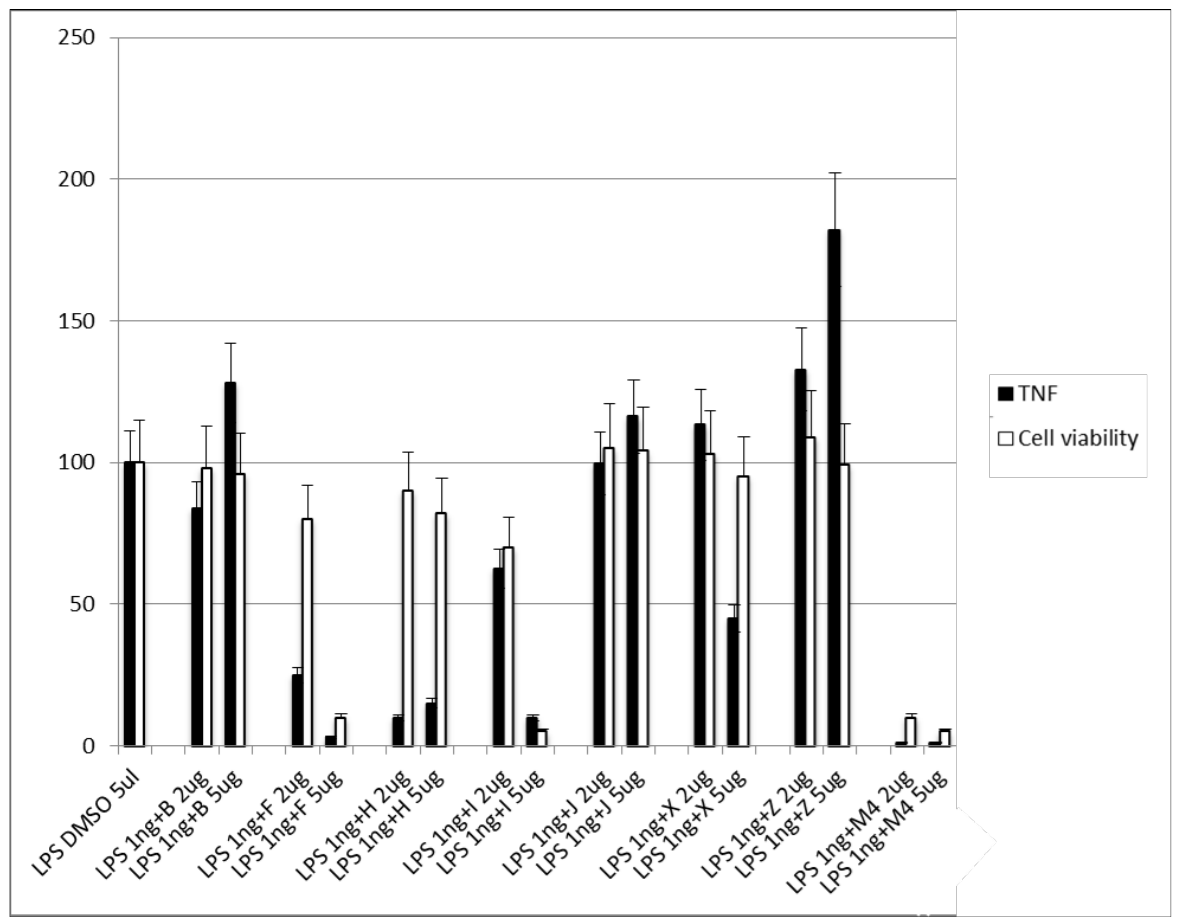
Figure 7. Expression of TNF- α secretion (black bars) and cell viability (white bars) in the J744 cell line upon treatment with the screened compounds B, F, I, J, X, Z, and M4. The results were normalized with the positive control (LPSs alone) and expressed as the mean percentage ± SD of at least three independent experiments.